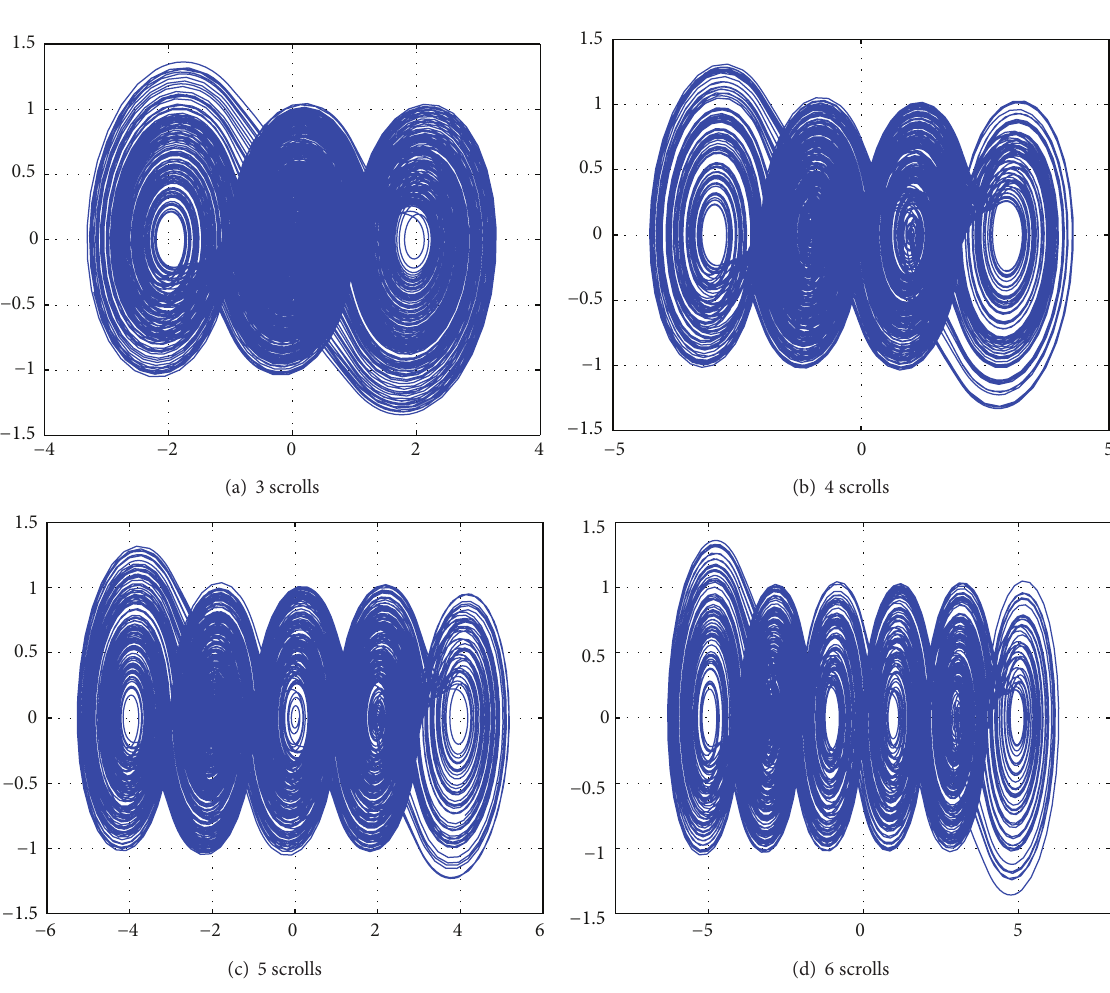
Figure 1: Basic SNLF cell with two saturated levels.